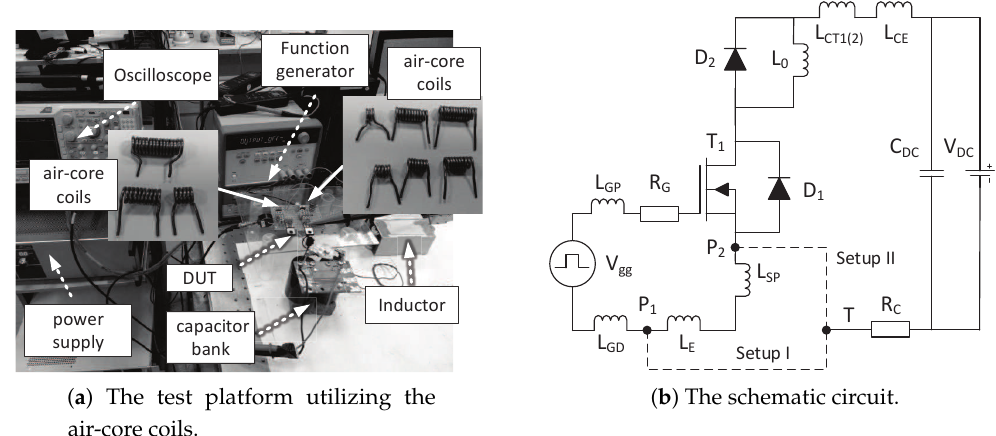
Figure 15. The test platform and the schematic circuit with air-core coils.